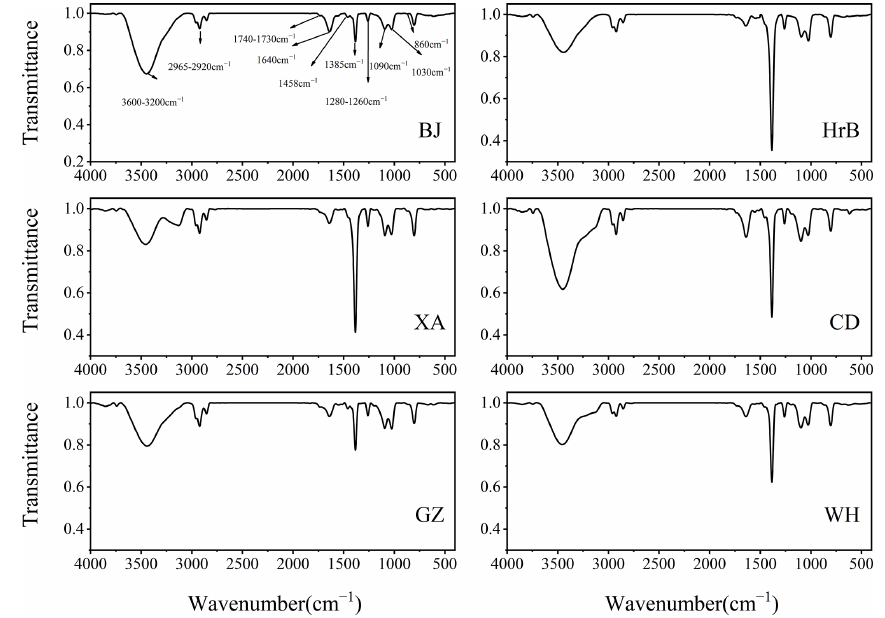
Figure 4. FT-IR spectra of BrC in the six